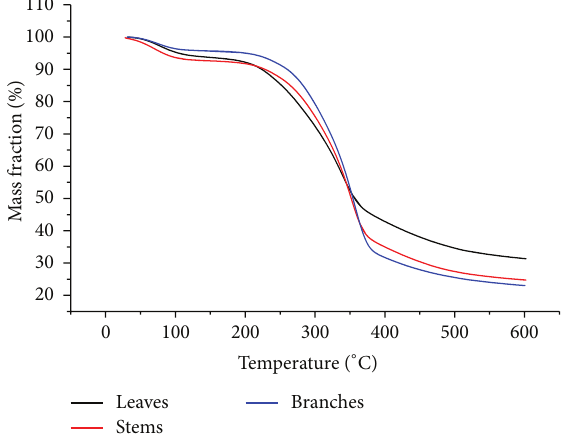
Figure 1: TGA curves for the three types of willow